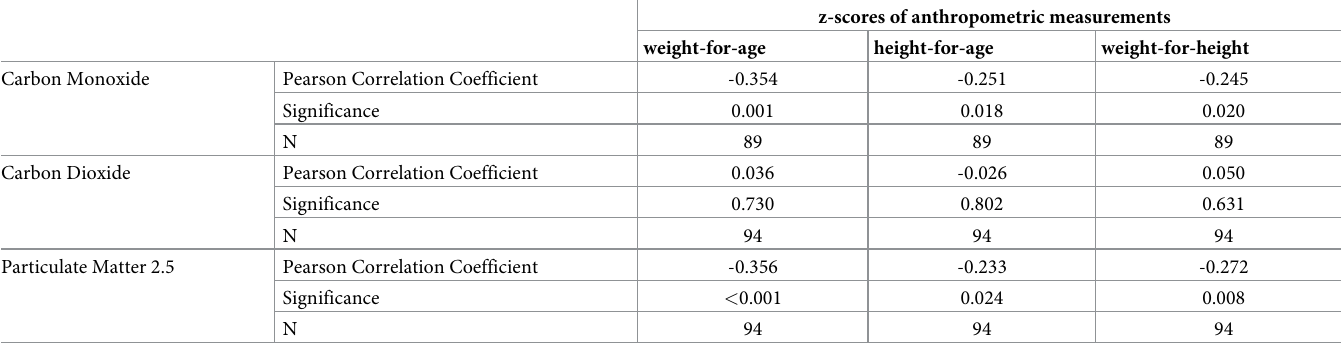
Table 6. Correlation between air quality levels and anthropometric